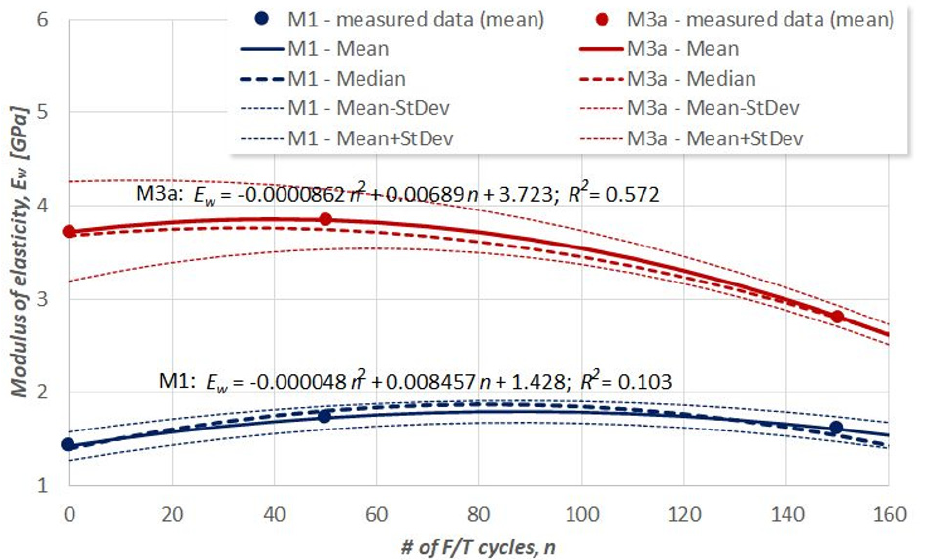
Figure 1. Mean and Mean ± Standard deviation regression curves for Young’s modulus, E w , for two types of mortar. Dashed line represents Median. Corresponding expressions for Mean are also pre- sented.